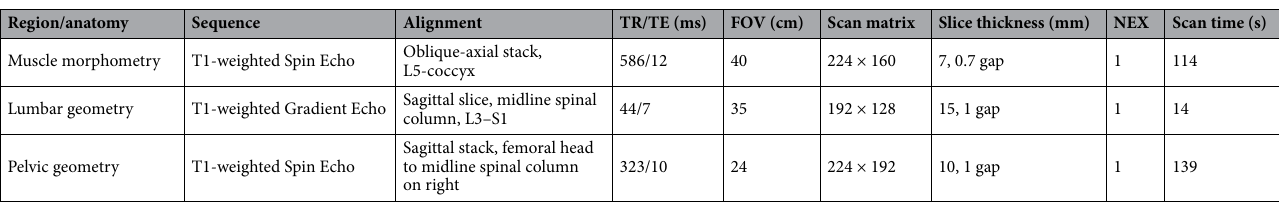
Table 1. Imaging sequence parameters.